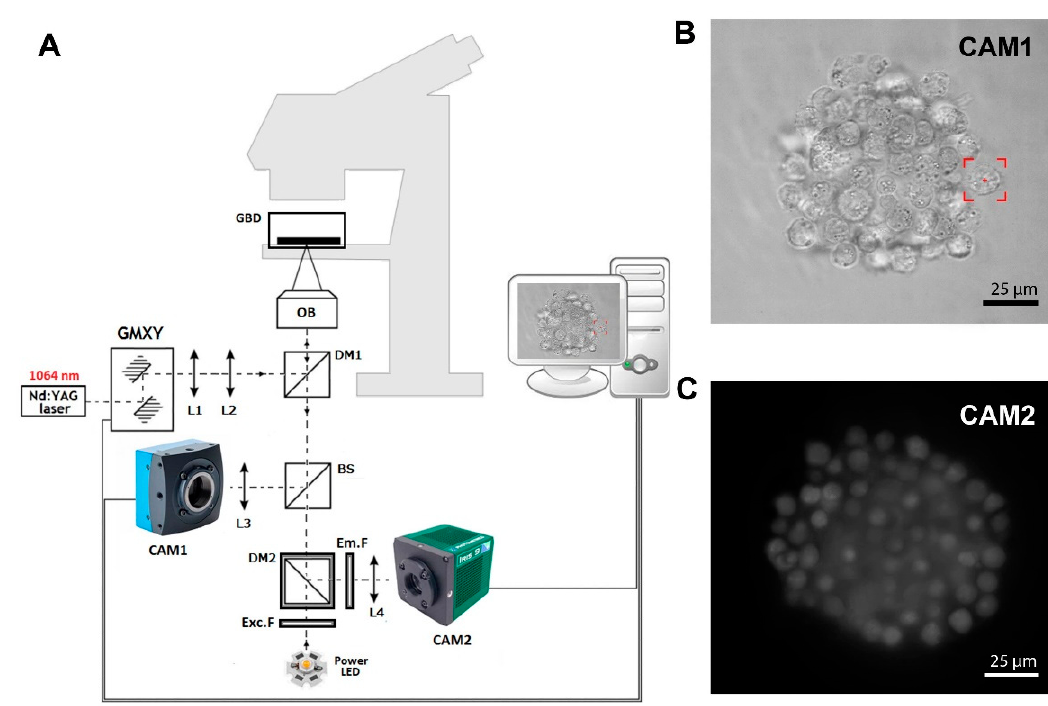
Figure 1. ( A ) In-house-developed fluorescence optical tweezers (FOT). L1, . . . , L4—lenses; DM1, DM2—dichroic mirrors; BS—beam splitter; GMXY—Galvano-mirror XY scanning system; OB—high NA numerical aperture objective; Exc.F—excitation filter; Em.F—emission filter; CAM1, CAM2—digital cameras 1 and 2. ( B ) The image of a hybrid spheroid taken in the brightfield by CAM1. The red box represents the optical trap. ( C ) The fluorescent image of a hybrid spheroid was taken by CAM2.